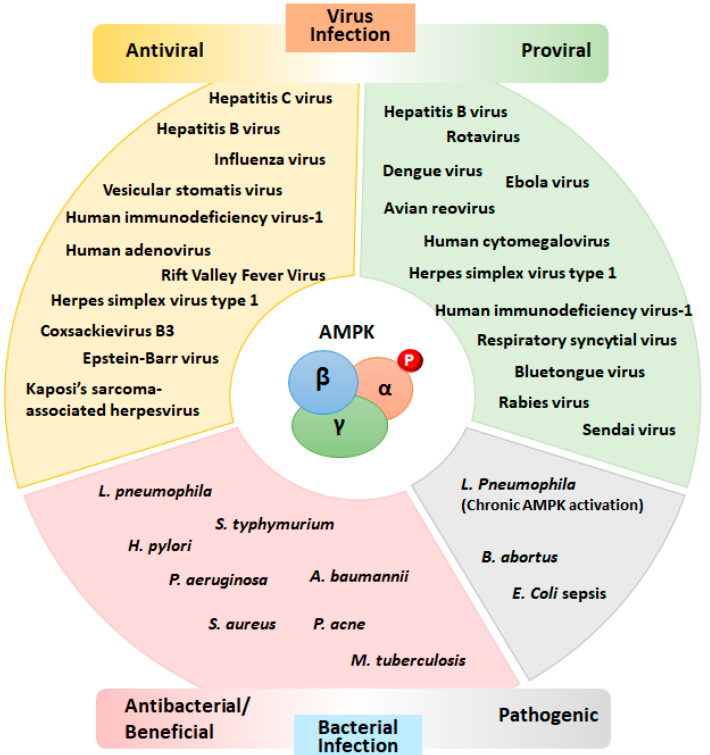
Figure 2. Multifaceted roles of AMPK in viral and bacterial infections. A variety of viruses and bacteria modulate host AMPK activity to promote their growth in host cells. Activation of the AMPK signaling pathway has been implicated in both beneficial antiviral ( left upper ) and detrimental proviral ( right upper ) responses. In addition, AMPK activation promotes the host response to infections by various bacteria ( left lower ) but, in some cases, promotes a detrimental response ( right lower ). The detailed mechanisms by which AMPK activation/inhibition affects infection outcomes are listed in Tables 1–4.